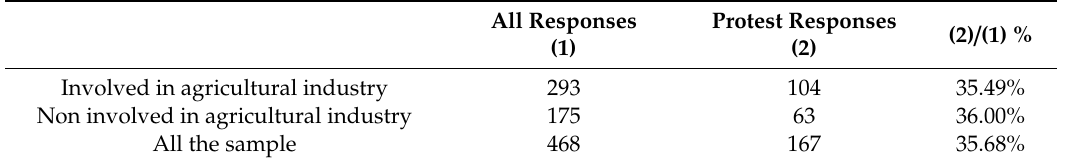
Table 3. Percentage of protest responses among respondents according to their link to the agricultural